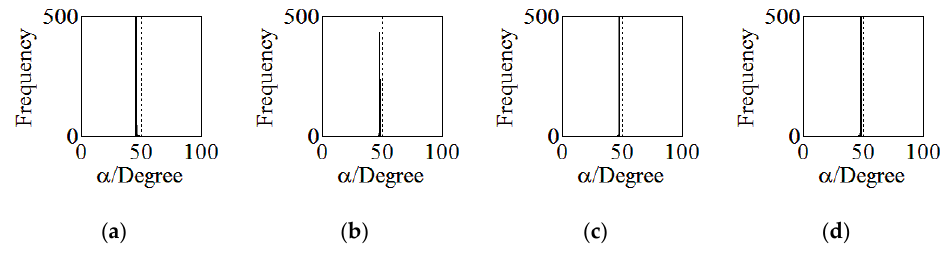
Figure 7. Histograms of DF EP for chaff clouds. ( a ) Case 1. ( b ) Case 2. ( c ) Case 3-1. ( d ) Case 3-2.